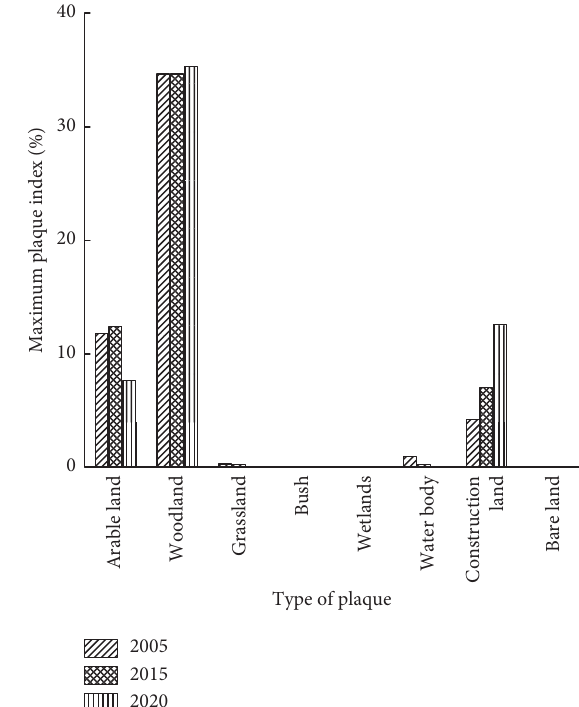
Figure 7: Changes in patch types of ecological urban landscape.